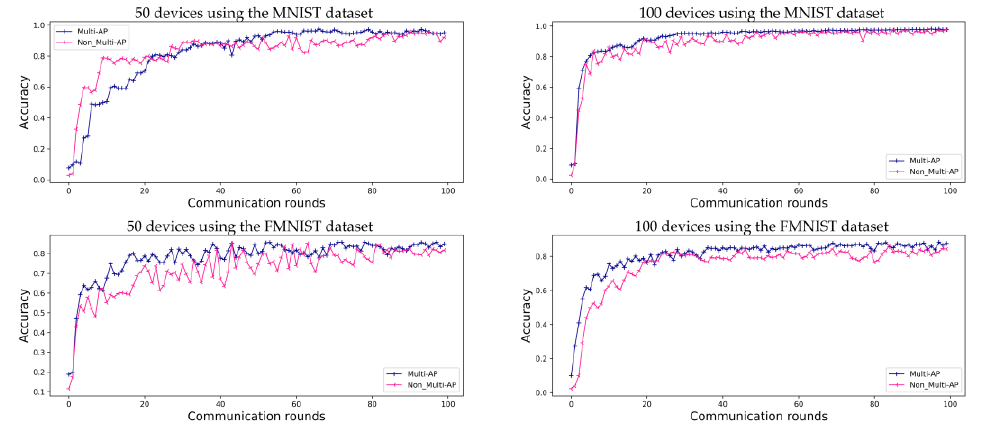
Figure 6. Evaluation of FL prediction using the MNIST and FMNIST datasets in environments with ten APs, for 100 communication rounds.